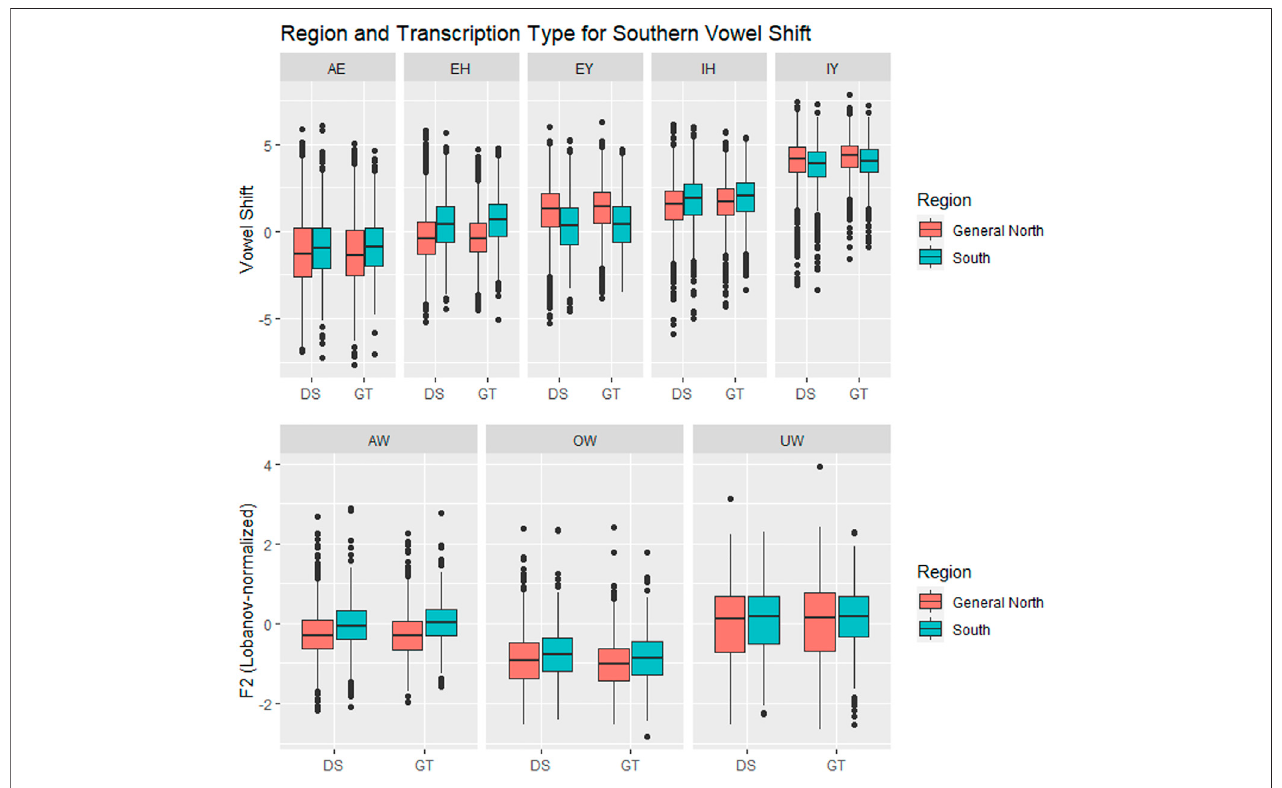
FIGURE 7 | Vowels in the Southern Vowel Shift, by Region (General North versus Southern) and transcription type. In six of the vowels (AW, EH, EY, IH, OW, UW) there is a signi fi cant separation between General North and Southern vowels, and this is tracked by both transcription systems. DS (cid:1) DeepSpeech, GT (cid:1) Ground truth.